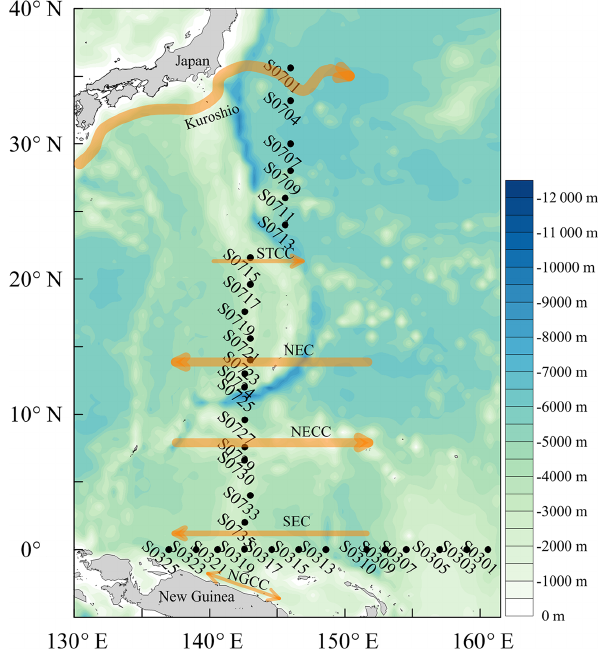
Figure 1. Locations of the sampling stations in the western tropi- cal North Pacific Ocean. The acronyms NGCC, SEC, NECC, NEC, and STCC stand for New Guinea Coastal Current, South Equatorial Current, North Equatorial Countercurrent, North Equatorial Cur- rent, and Subtropical Countercurrent,